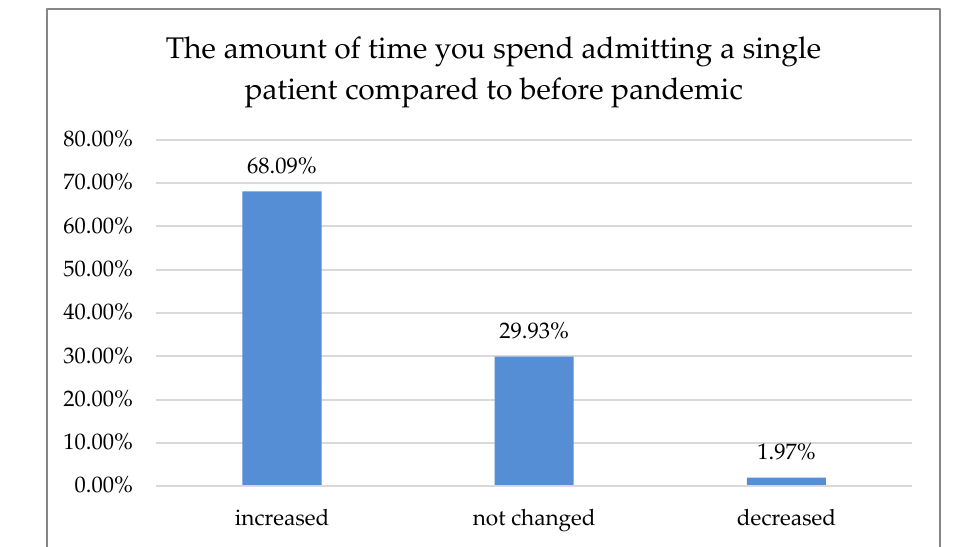
Figure 6. Amount of time spent per one patient during the pandemic. Of the interviewed dentists, 13.53% were infected with the coronavirus (Figure 7).